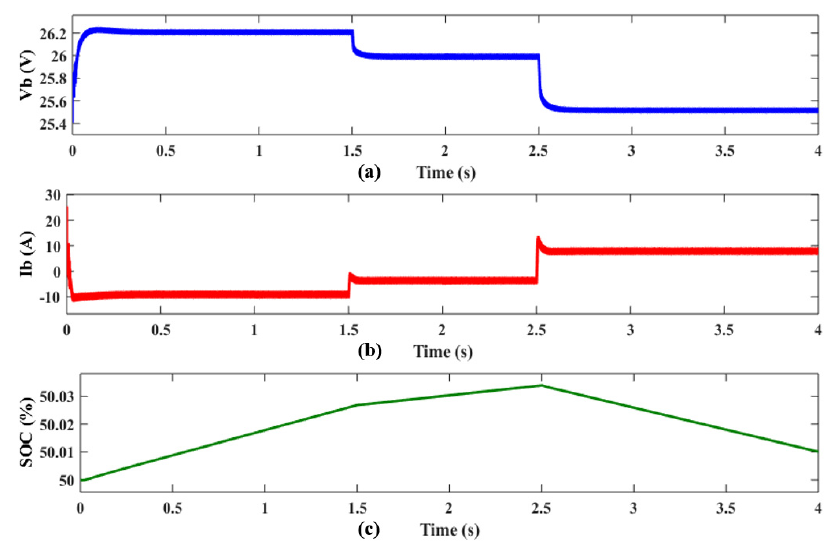
Figure 13. MPPT with trapezoidal MF—( a ) PV voltage ( b ) PV current ( c ) Fuel cell current ( d ) Fuel cell voltage.